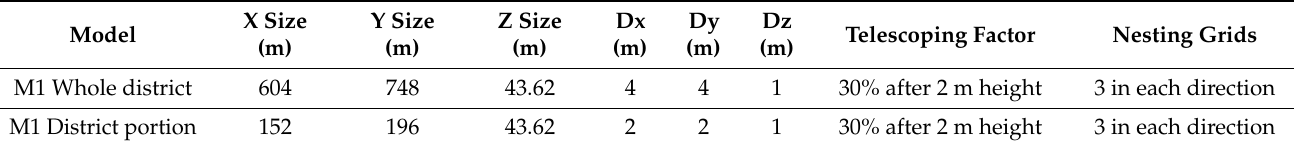
Table 11. Model geometry settings in the ENVI-MET Spaces module.